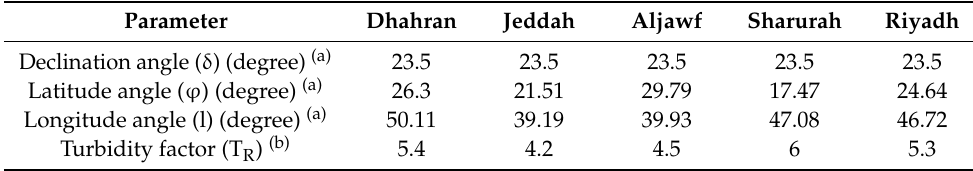
Table 1. Geographical parameters of selected cities. Parameter Dhahran Jeddah Aljawf Sharurah Riyadh Declination angle ( δ ) (degree) (a) 23.5 23.5 23.5 23.5 23.5 Latitude angle ( ϕ ) (degree) (a) 26.3 21.51 29.79 17.47 24.64 Longitude angle (l) (degree) (a) 50.11 39.19 39.93 Turbidity factor (T R )